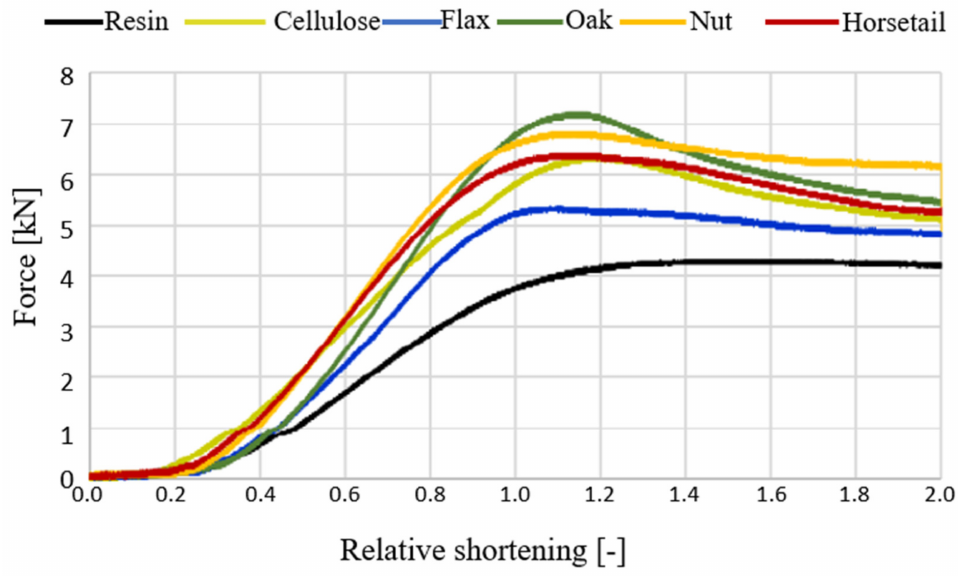
Figure 14. Compression force dependence on relative shortening in the compression test for samples with 2.5% addition. Table 2. Compressive strength test